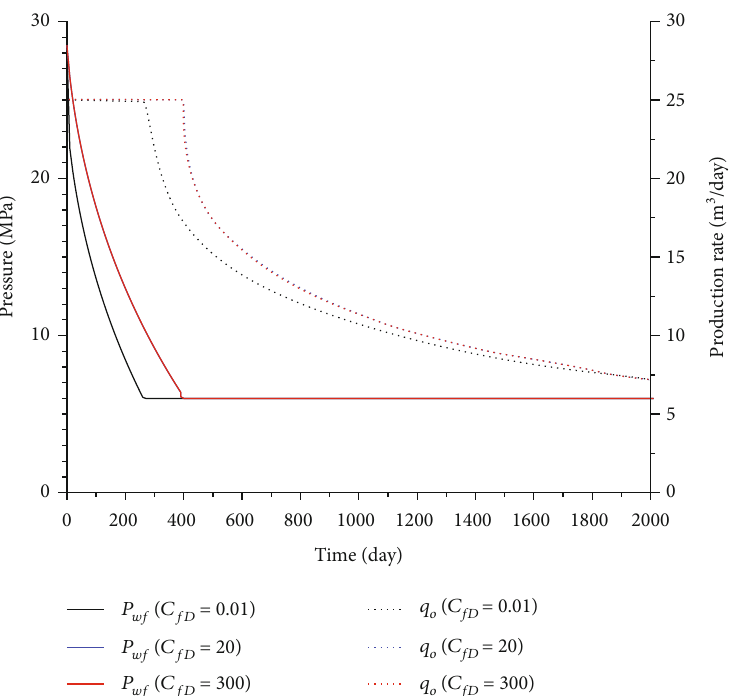
Figure 14: The e ff ect of fracture conductivity on well performance (compound working system).